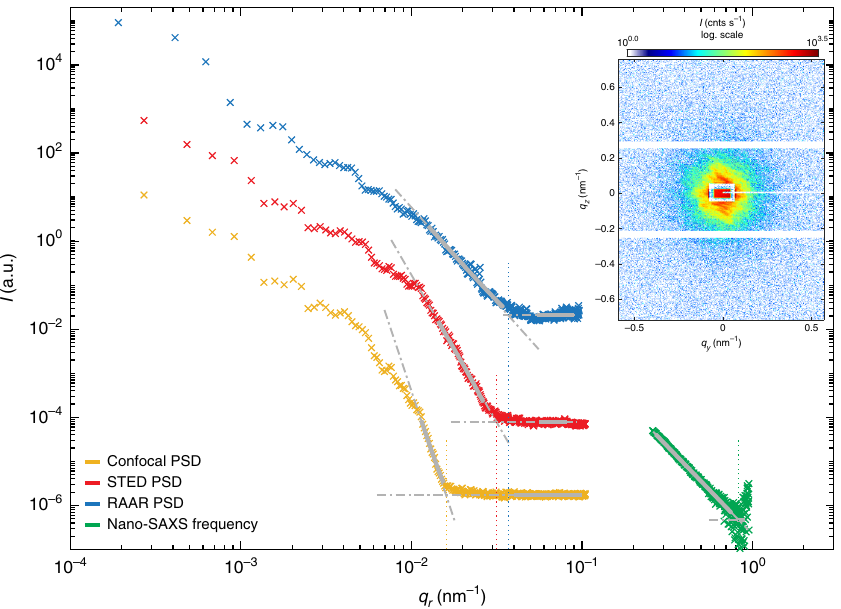
Fig. 4 Power spectral densities (PSDs) of the confocal (yellow) and STED micrograph (red), the phase reconstructed image of the X-ray holography experiment (blue), along with the SAXS structure factor (power-law decay), all shown as a function of the scattering vector q r . For a direct comparison, all PSD values are transformed into a q -equivalent by rescaling the x -axis with a factor of 2 π . The cross-over to the noise fl oor is determined to q i = 0.016, 0.032, 0.037, and 0.83 nm − 1 , for confocal, STED, holography and scanning SAXS data, respectively. Intensity values are shifted for clarity. The inset shows a typical diffraction pattern recorded in the nucleic